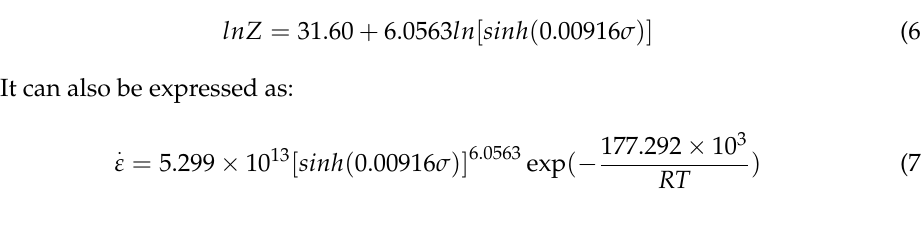
Figure 7. ( a ) The linear relationships of lnZ versus ln [ sinh(ασ) ]; ( b ) comparison of experimental and calculated peak stress of the 13Zn alloy.